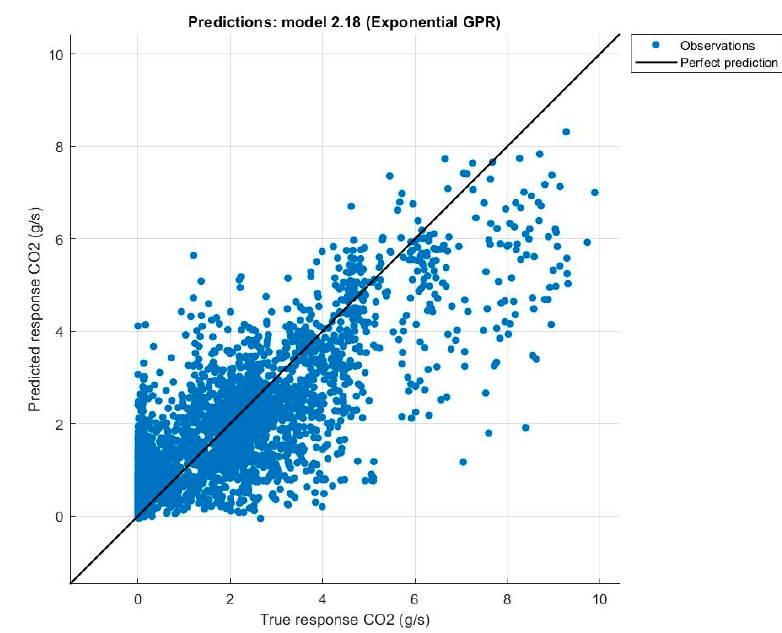
Figure 7. Predicted vs. true response scatter plot for the CO 2 emissions.